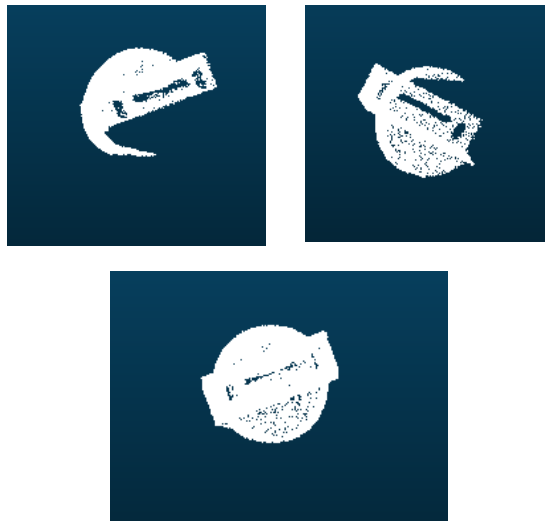
Figure 3: Point clouds before and after transformation in the case of ToF laser scanner (Kontogianni et al.